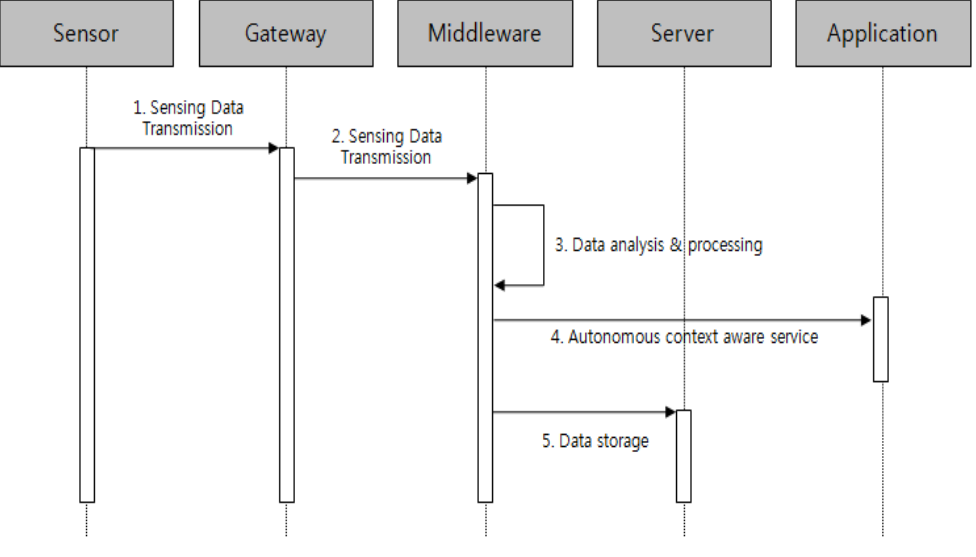
Figure 7. Sequence diagram of context aware service.